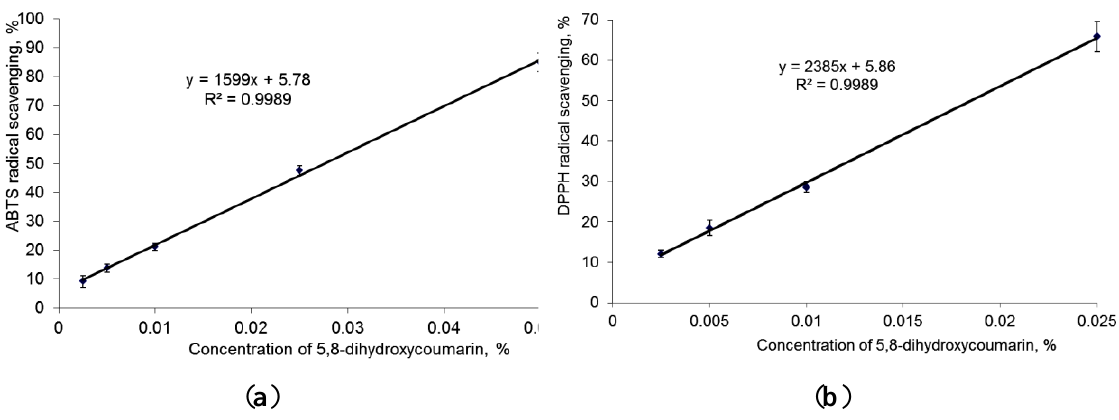
Figure 2. Effect of 5,8-dihydroxycoumarin concentration on radical scavenging